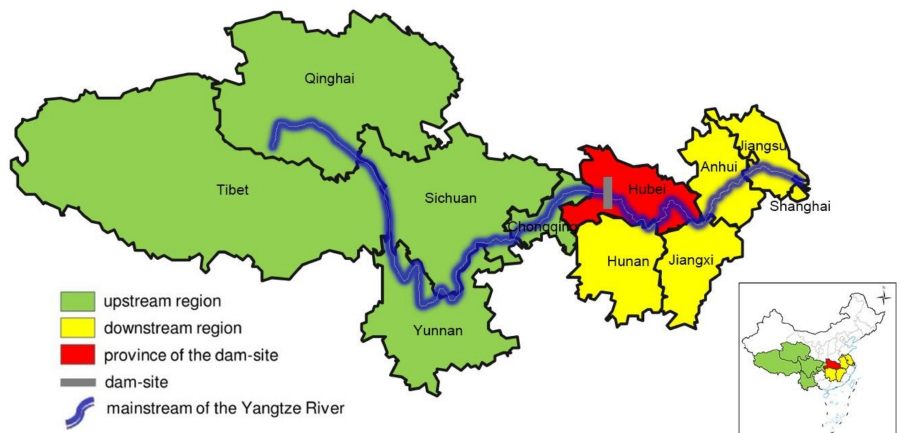
Figure 1. Map of the Yangtze River area and the TGD. Note: The base image for this map is from https://datav.aliyun.com/portal/school/atlas/area_selector (accessed on 26 May 2022).